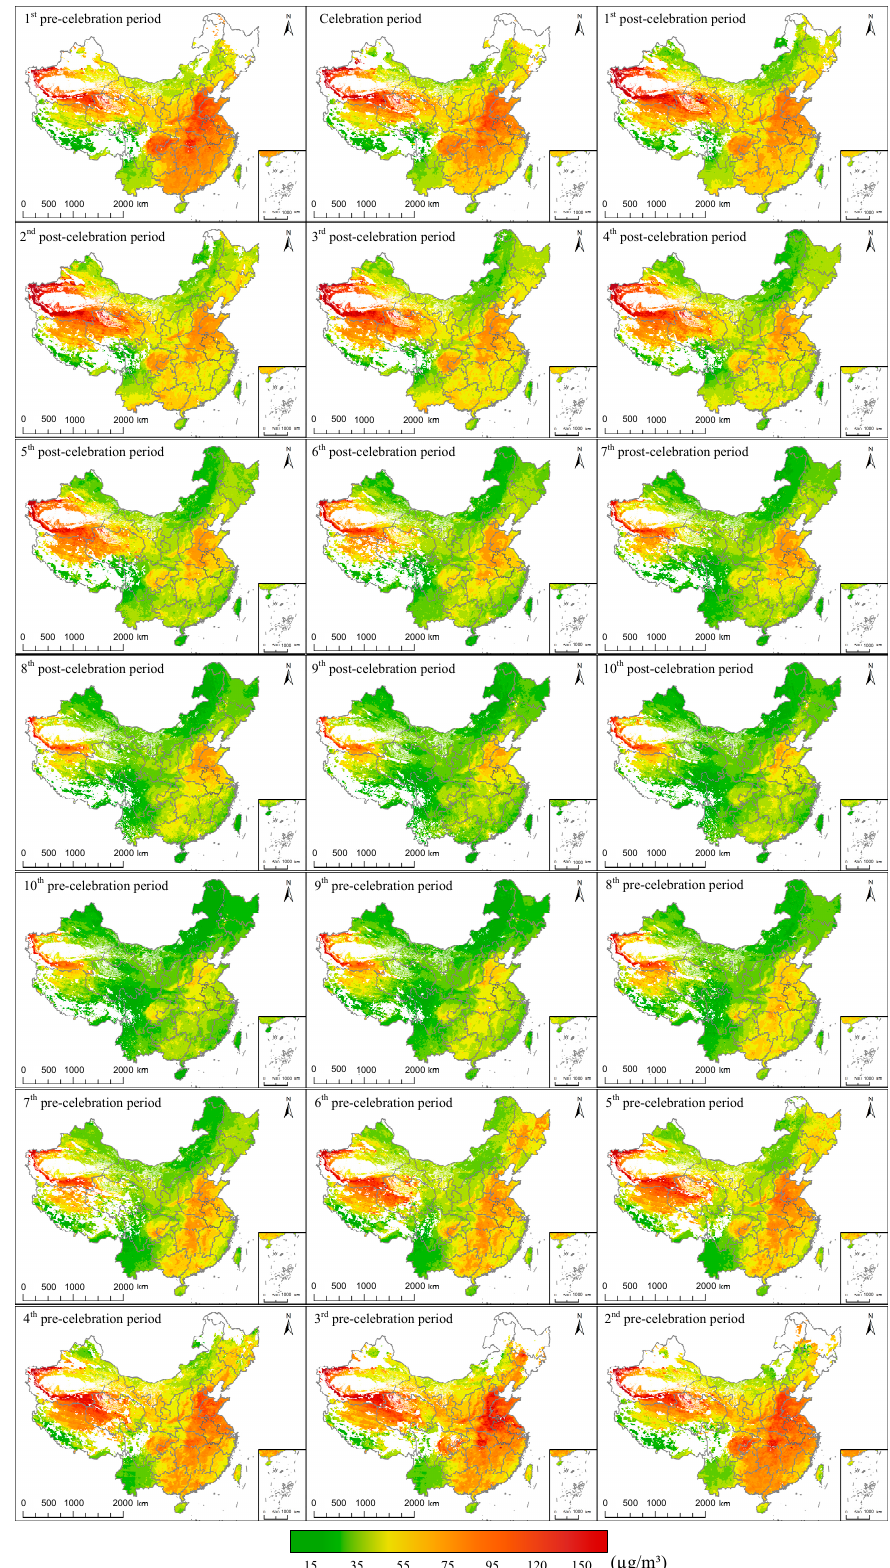
Figure 7. Fused PM 2.5 distribution maps for mainland China from 2002 to 2016. The fusion maps are basically arranged in chronological order.